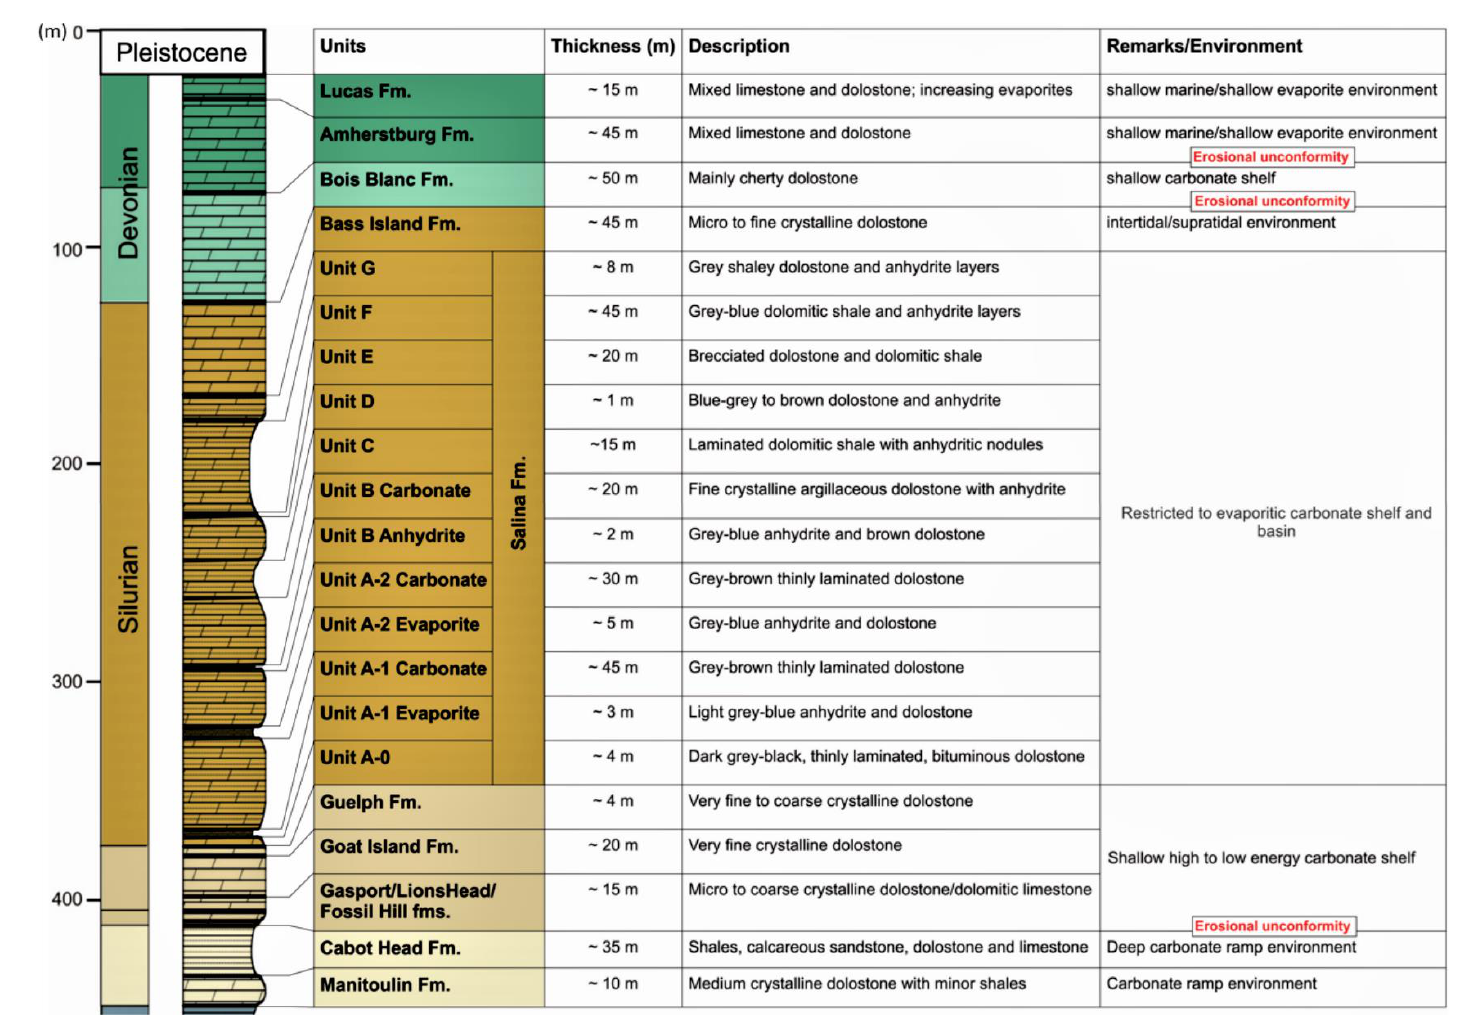
Figure 2. Summary of the Silurian and Devonian stratigraphy in the study area (modified from Johnson et al. [18]; AECOM [25]; Armstrong and Goodman [34]).